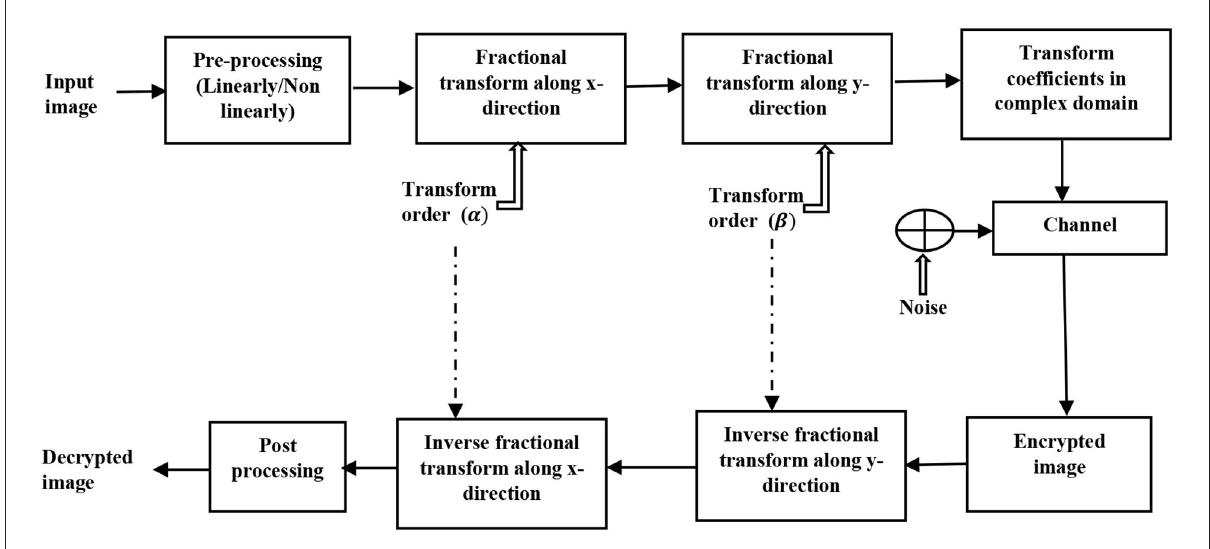
FIGURE3 Schematic architecture for Fractional transform-based image encryption in digital